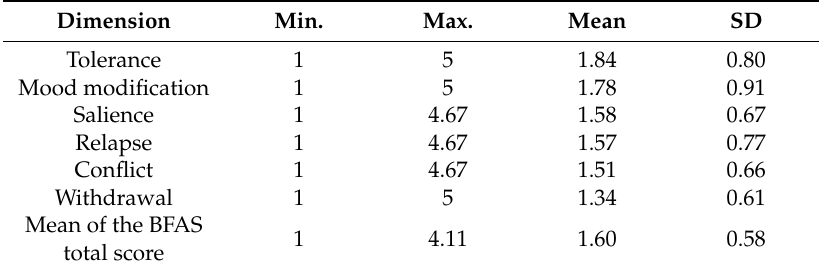
Table 1. Results of descriptive of the Facebook Addiction Scale dimensions.